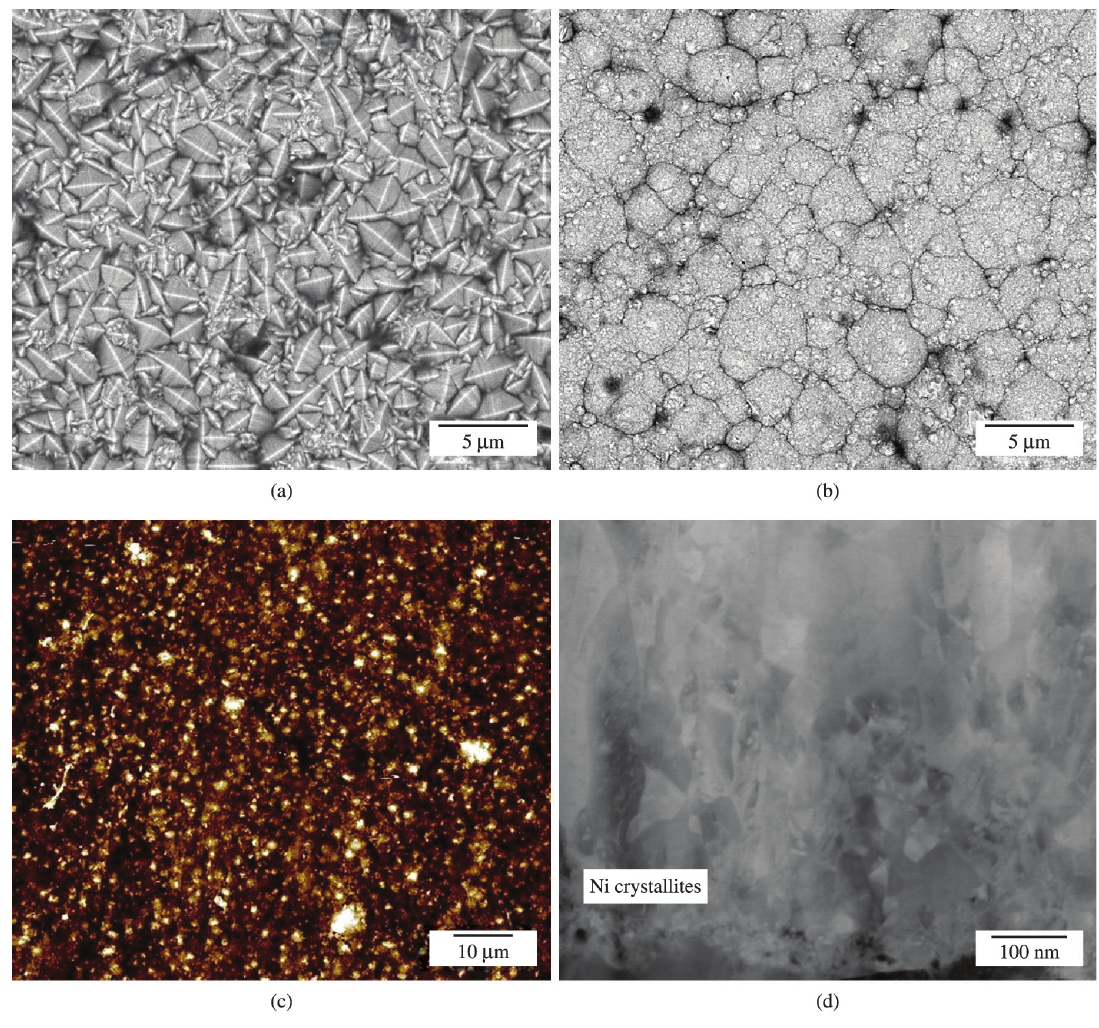
Figure 1. Surface morphologies of Ni produced by: (a) dc electrodeposition showing coarse pyramidal grains and (b) pulse electrodeposition showing fine equiaxed grains. (c) AFM (scale: x=100, y=100 and z=1.89 microns, step size 1.4 microns) and (d) Cross-sectional HAADF images of fine grained pulse Ni electrodeposit showing fine-grained structure. (HAADF – High Angle Annular Dark